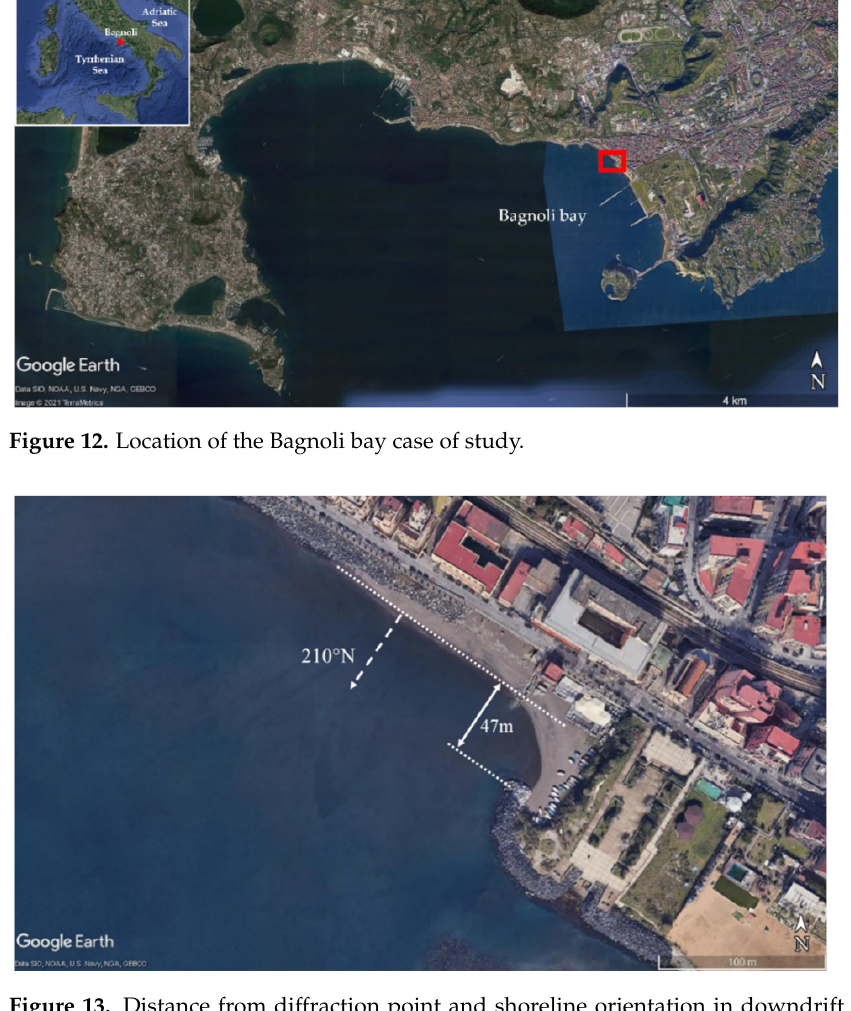
Figure 13. Distance from diffraction point and shoreline orientation in downdrift section of the Bagnoli bay case